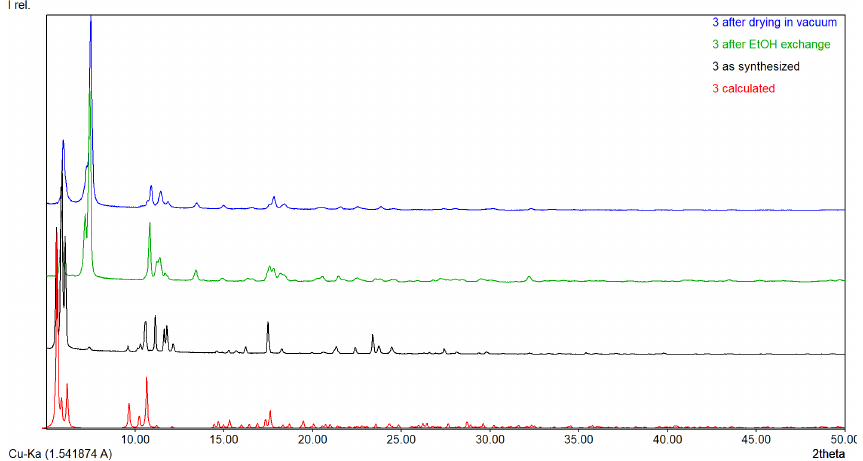
Figure 7. Diffractograms corresponding to compound 3 calculated from the cif file (red), as synthesized (black), after exchange with EtOH (green), and after drying in vacuum (blue).